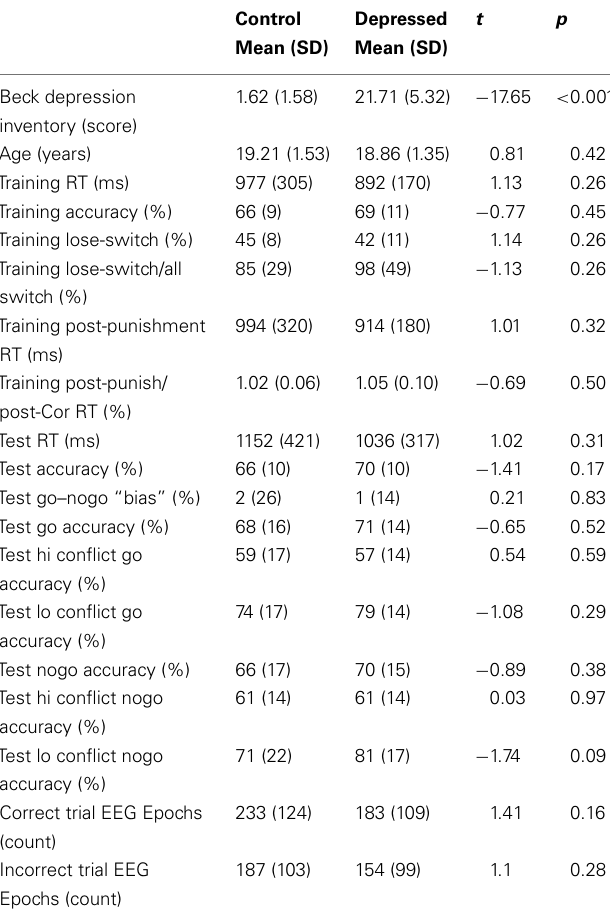
Table 1 | Group means, SD, and t -test results for demographics, task performance, and EEG